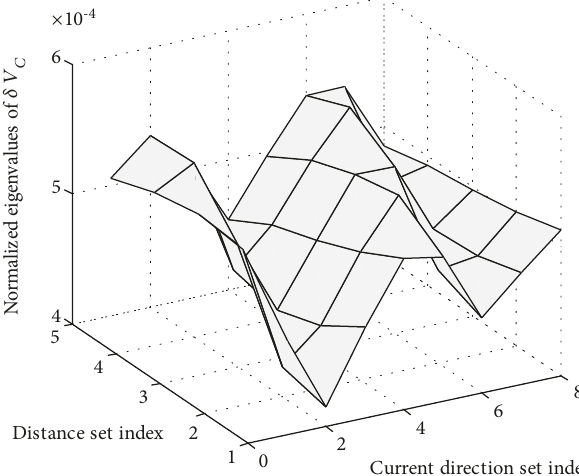
Figure 13: Normalized eigenvalues of the heading angle error δϕ under di ff erent current direction and distance conditions. Figure 14: Normalized eigenvalues of the estimated current speed error under di ff erent current direction and distance